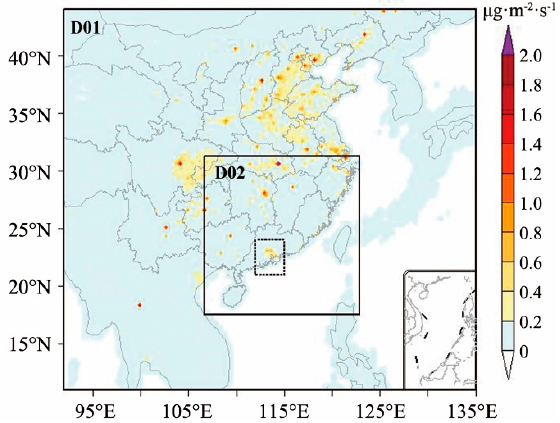
Figure 4. The two nested domains and spatial distribution of PM 2.5 emissions (shading; unit: µ g · m − 2 · s − 1 ). The area enclosed by the dotted line is the DS